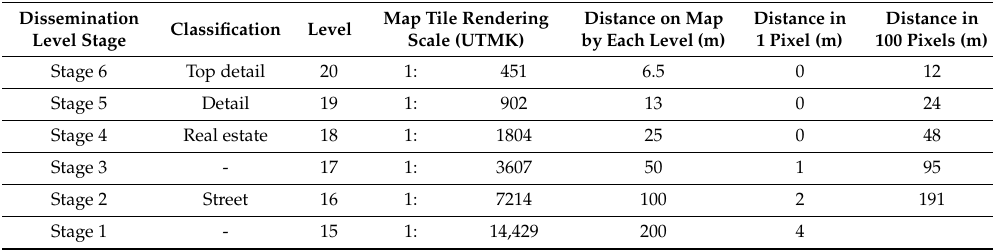
Table 2. Stages of map dissemination levels.